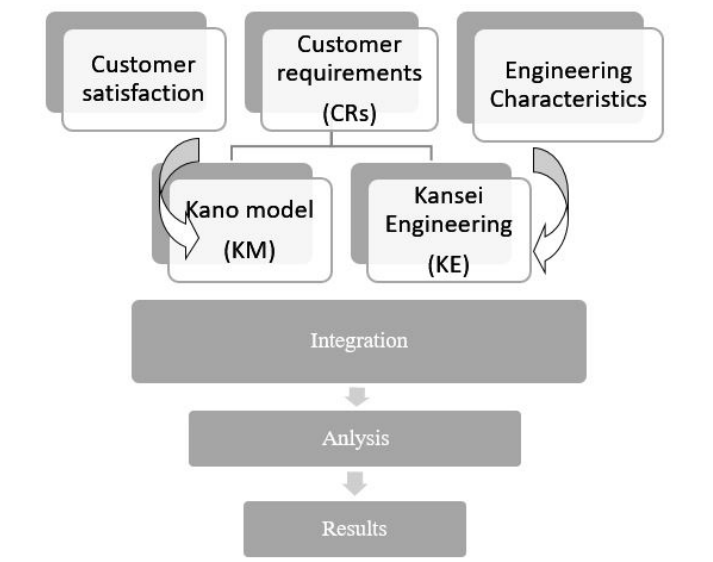
Figure 1. The integration approach between KE &